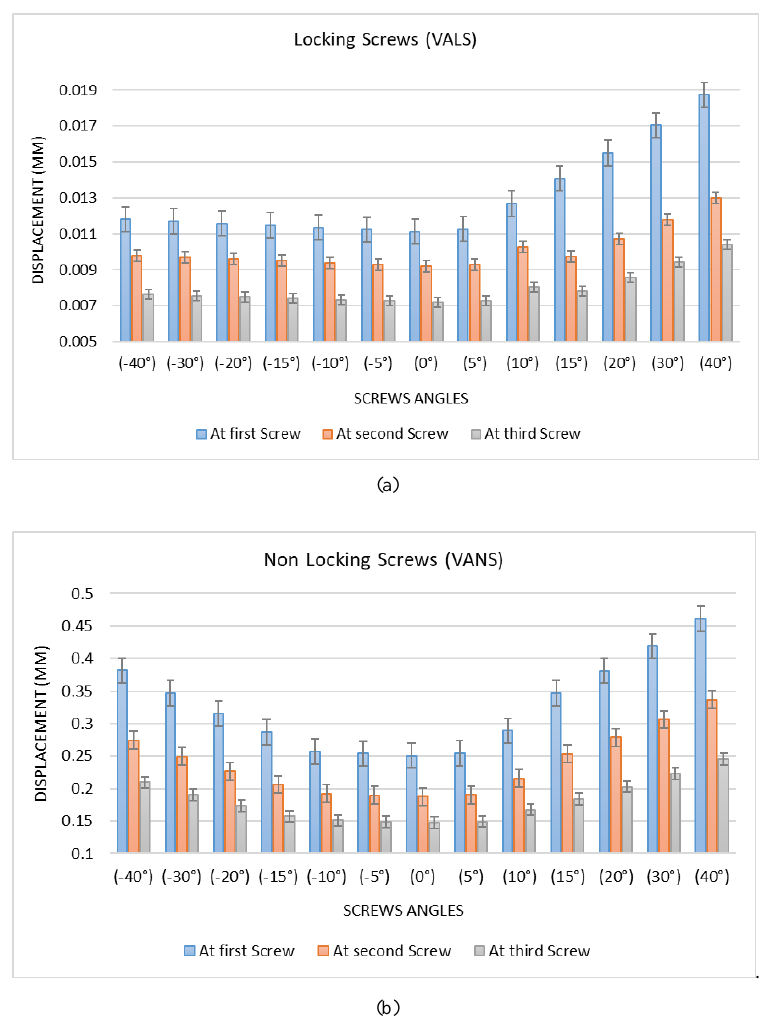
Figure 11. ( a ) VANS displacement. ( b ) VALS displacement.